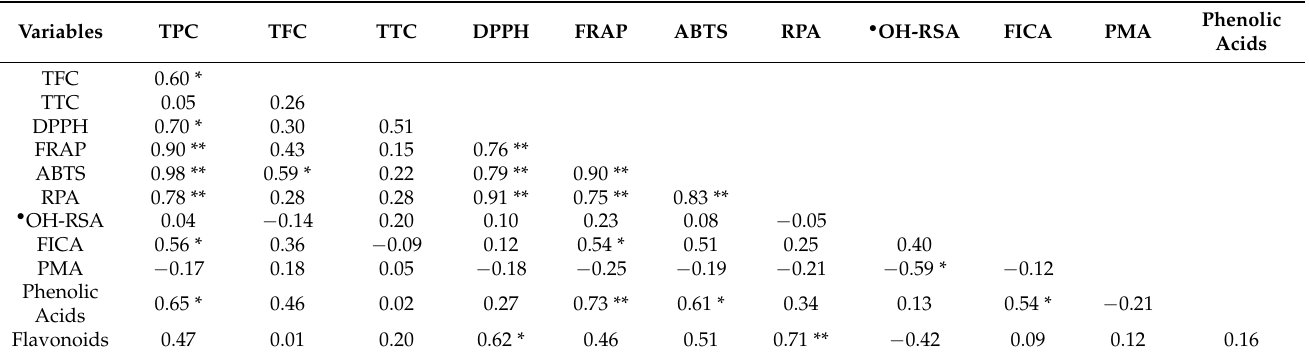
Table 3. Pearson’s correlation between antioxidant capacity by different antioxidant